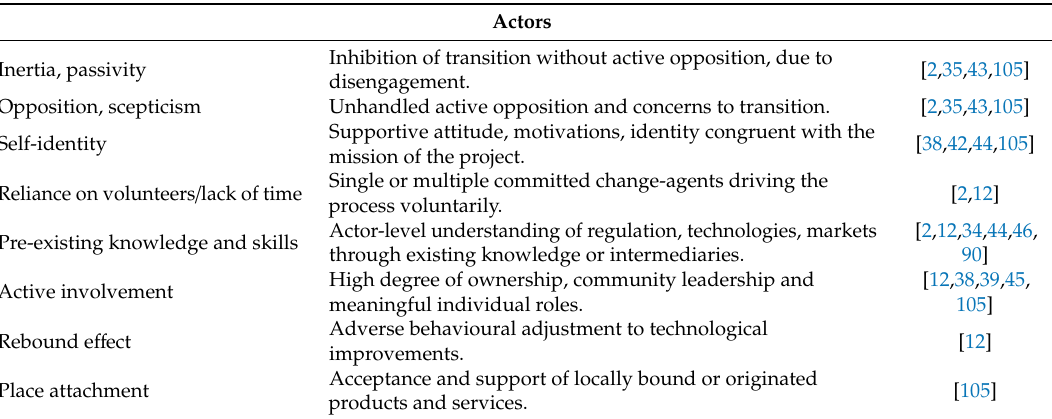
Table 7. Actor-bound progression